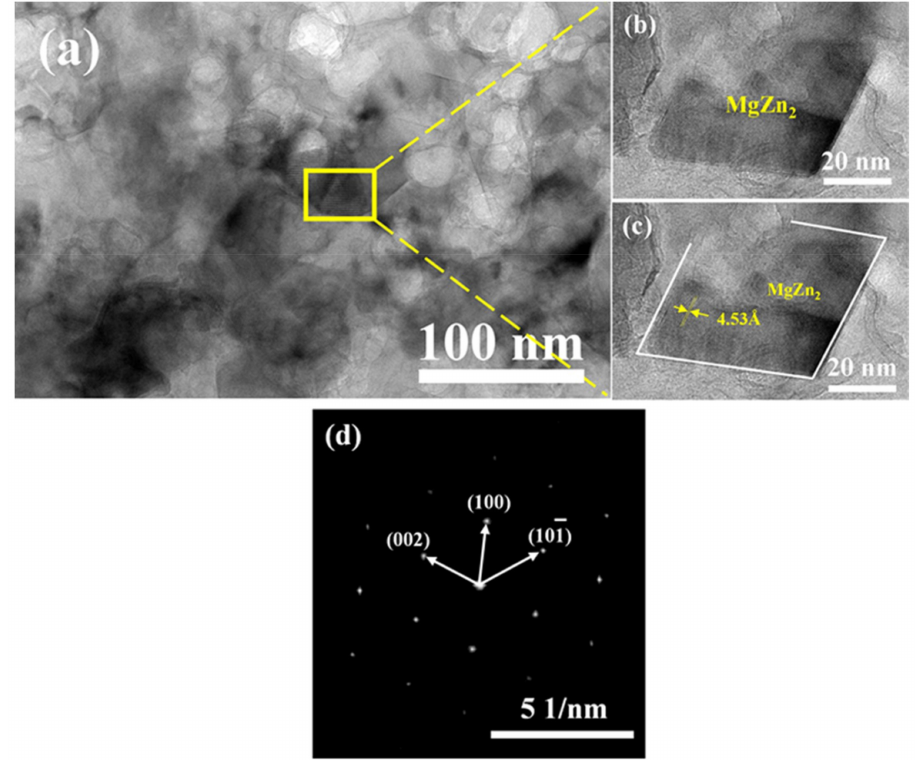
Figure 10. TEM analysis of S30 samples ( a ) S30 TEM micrograph, ( b , c ) HRTEM micrograph of MgZn 2 nanoparticle and ( d ) Fast Fourier Transform (FFT) image of MgZn 2